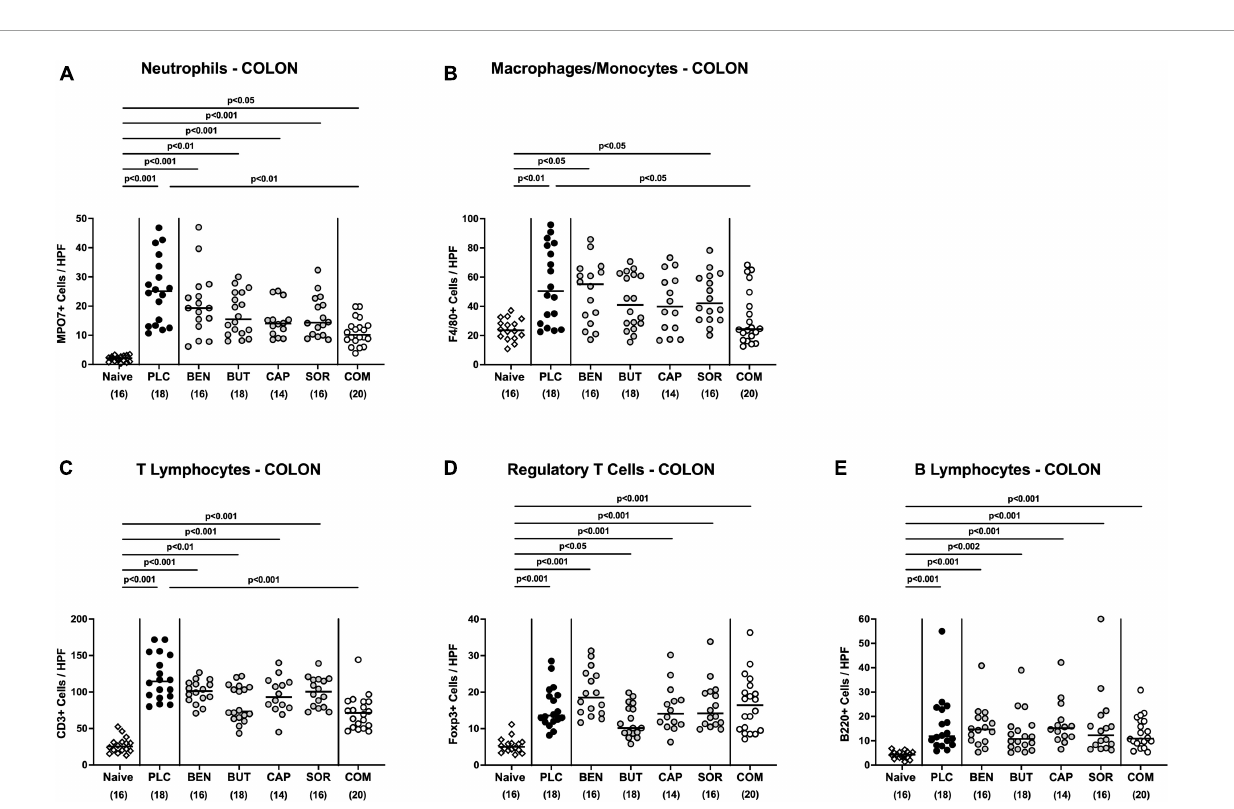
FIGURE5 Colonic immune cell responses upon single and combined organic acid treatment. Starting on day 2 post-infection, C. jejuni infected mice received a 4-day treatment with benzoic acid (BEN), butyric acid (BUT), caprylic acid (CAP), sorbic acid (SOR), a combination of all acids (COM) or placebo (PLC). On day 6 post-infection, the average numbers of (A) neutrophils (positive for MPO7), (B) macrophages and monocytes (positive for F4/80), (C) T lymphocytes (positive for CD3), (D) regulatory T cells (positive for Foxp3), and (E) B lymphocytes (positive for B220) in the colonic mucosa and lamina propria from six high power fields (HPF, 400 × magnification) per animal were assessed in immunohistochemically stained colonic paraffin sections. Naive mice served as uninfected and untreated controls. Medians (black bars), significance levels ( p values) calculated by the ANOVA test with Tukey’s post-correction or by the Kruskal–Wallis test and Dunn’s post-correction, and the total mice numbers (in parentheses) are given. Data were pooled from three independent